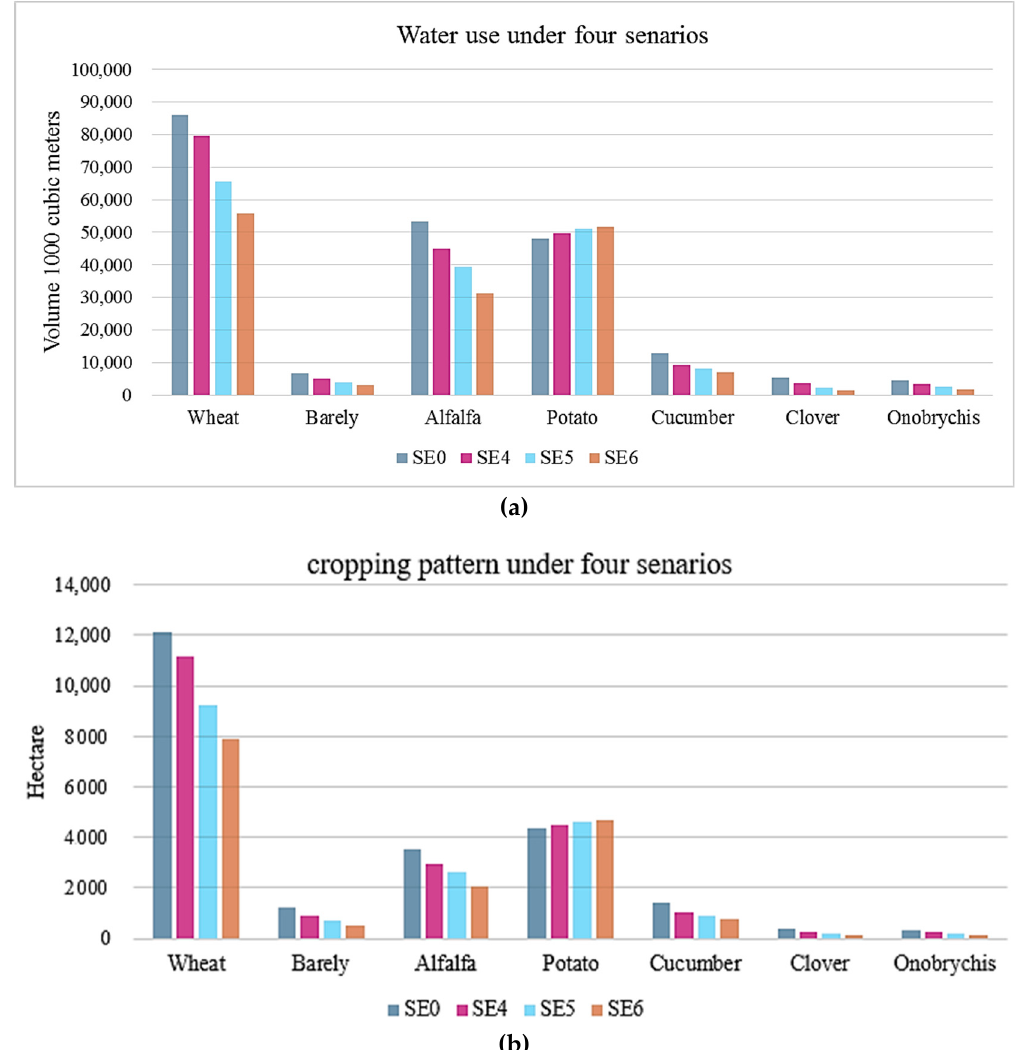
Figure 3. The effect of groundwater quota scenarios on ( a ) consumed water level and ( b ) cultivation pattern. ( see Table A2 for details )